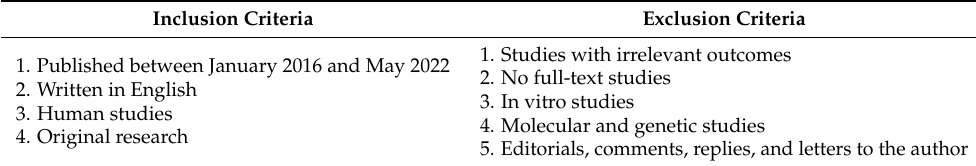
Table 1. Selection